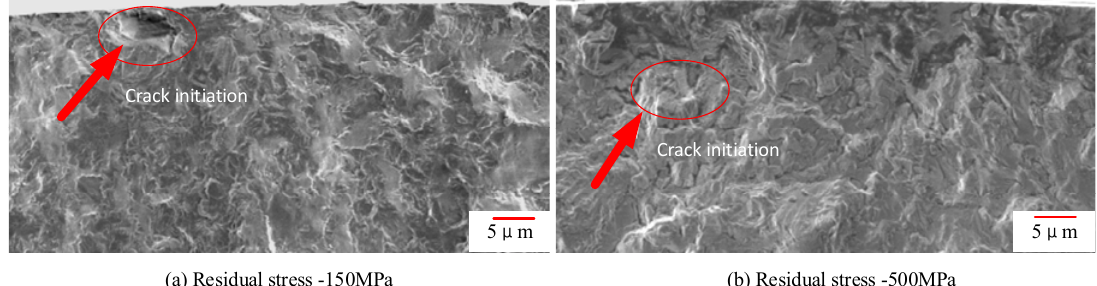
Figure 13. Fatigue crack initiation under different residual stresses in a cross-section view: ( a ) under the residual stress of − 550 MPa; ( b ) under the residual stress of − 500 MPa.